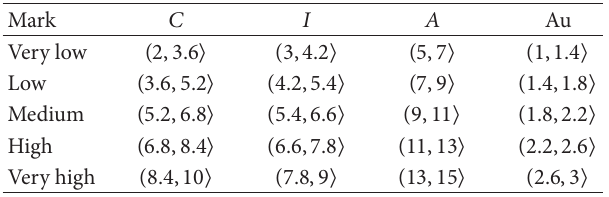
Table 9: The ranges for the qualitative interpretation of QoP evaluation of the analysed versions of TLS protocol.